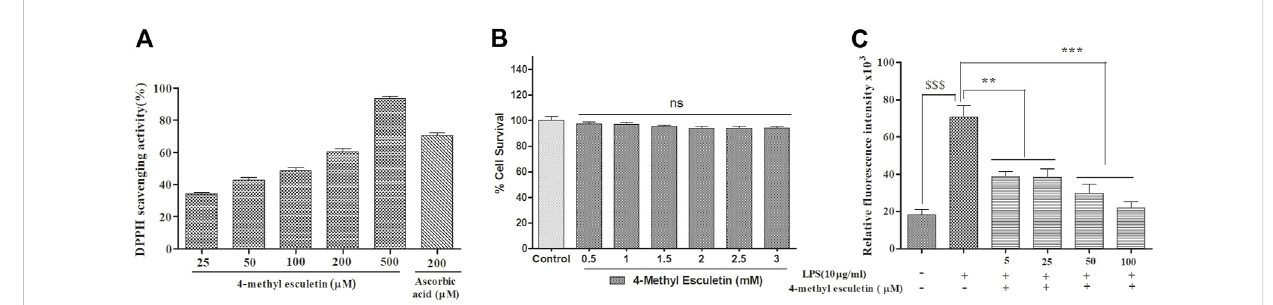
Anti-oxidant activity was evaluated by DPPH scavenging, ROS estimation and cytotoxicity by MTT. (A) Anti-oxidant ef fi cacy was evaluated by the DPPH assay with an increasing concentration of 4-MESC and ascorbic acid taken as a positive control. (B) Cytotoxicity of 4-MESC was evaluated on the RAWcelllineupto3 mMconcentrationbyanMTTassay. (C) ROSwereestimatedbyanH 2 DCFDAdyeaftertheLPStreatmentandalongwiththedifferent concentrations of 4-MESC. Data were represented as mean ± SD and * p < 0.05, ** 0.05 < p < 0.01, and *** 0.01 < p < 0.001 were considered signi fi cant compared to the LPS